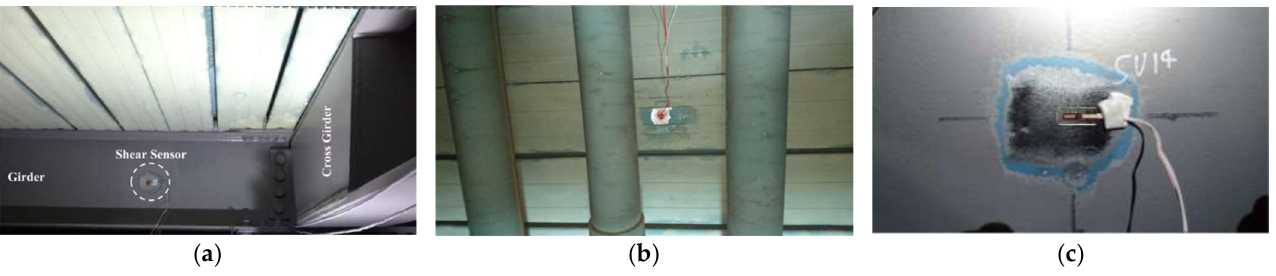
Figure 6. Sensor location on the cable-stayed bridge [30]. ( a ) Shear strain gauge on the web of the girder; ( b ) uniaxial gauge under the deck; ( c ) uniaxial gauge under the flange of the girder.